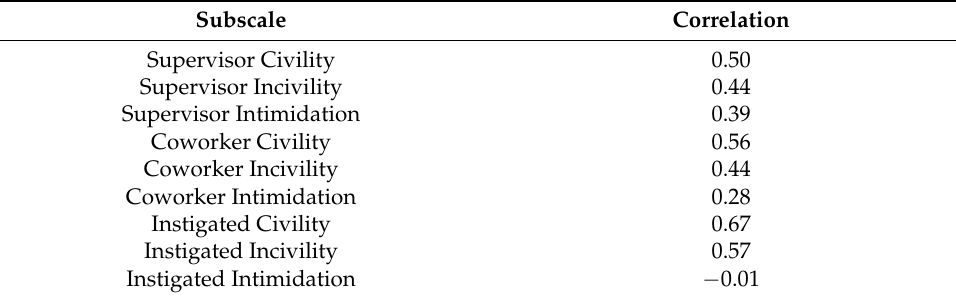
Table 2. Correlation of Time 1 with Time 2 SES constructs.